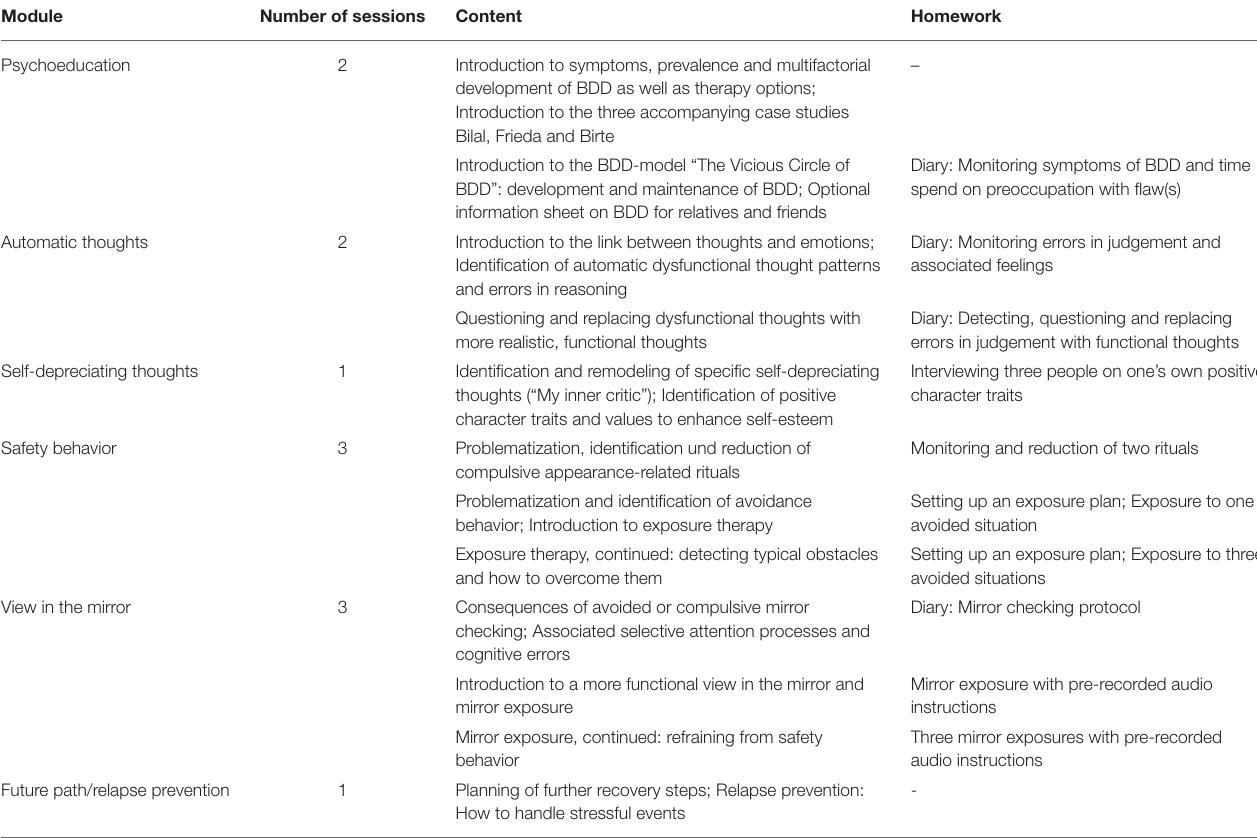
TABLE 1 | Description of modules, their number of sessions and content, and associated homework.